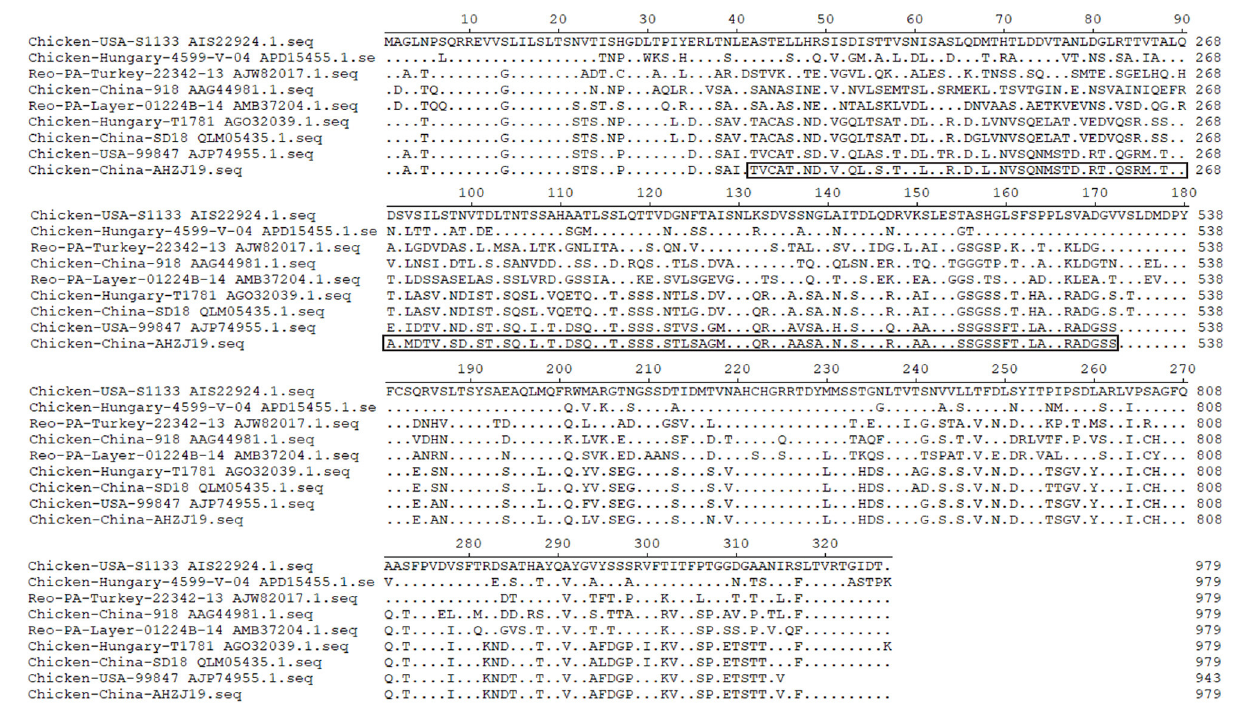
FIGURE 6 | Alignment of AHZJ19 and eight reference strains based on σ C protein. The alignment was constructed using the ClustalW methods in Megalign program included in the Lasergene 7.0 software